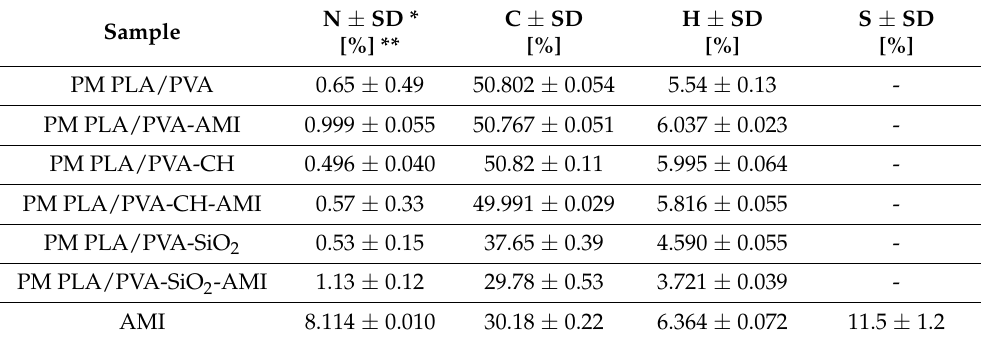
Table 2. Results of elemental analysis (Arc Flash) of the materials in the form of porous matrices. Sample